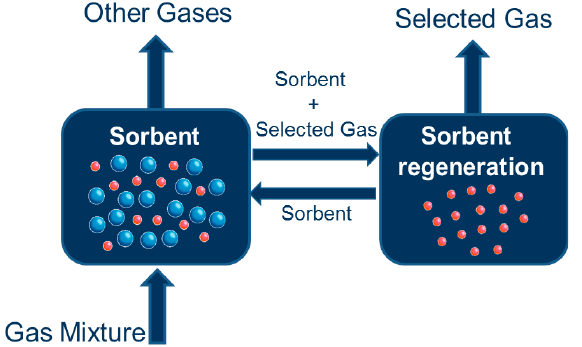
Figure 5. Illustration of the pressure swing adsorption technique. The technology works under pressure by using the adsorbent’s differences in gas adsorption rate to separate some gases from a gaseous mixture (Adapted from Ref.